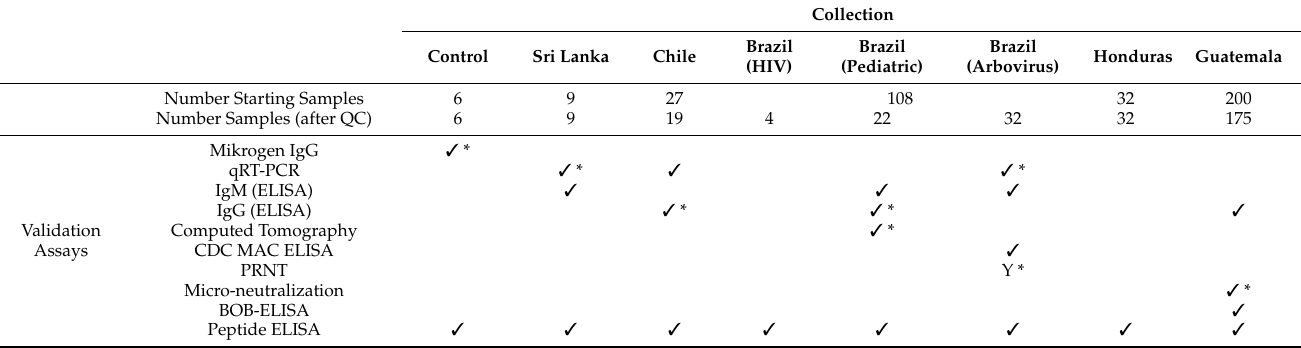
Table 1. Sera collections, validations assays, and comparisons reported in this